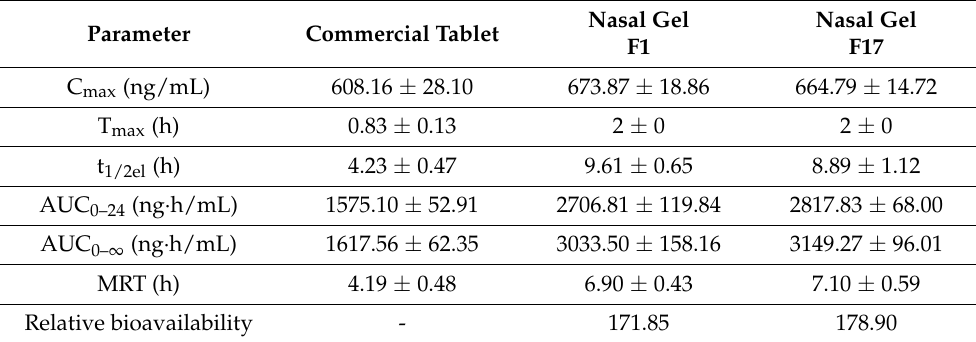
Table 3. Mean pharmacokinetic parameters ( ± SD) after oral administration of commercial tablets and nasal administration of in situ gel formulations F1 and F17 to